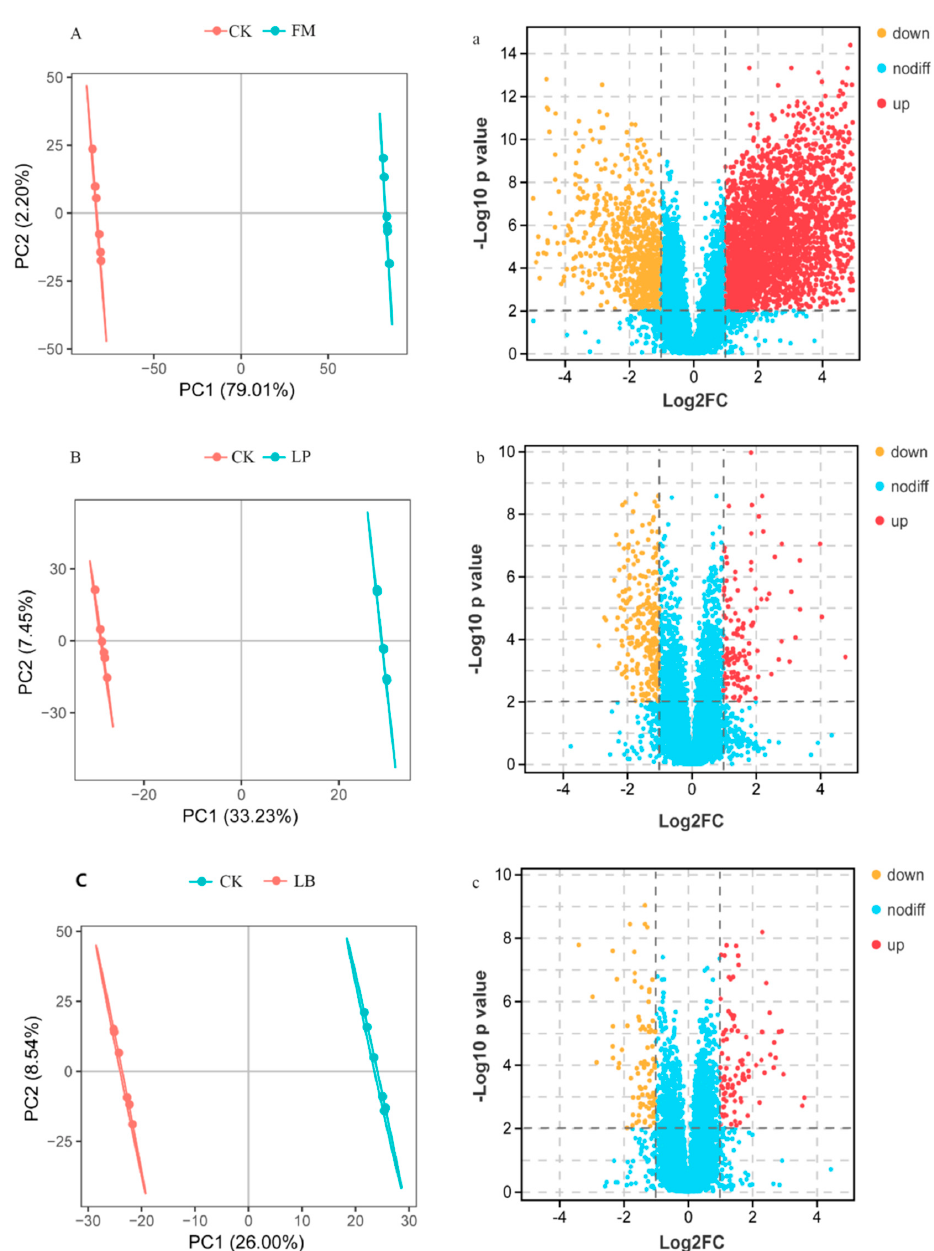
Figure 2. Differential volcano plots of metabolite differences of whole crop corn silage. Note: ( A – C ) is principal component analysis of metabolites in whole crop corn silage with different treatments. ( a – c ) is differential volcano plots of metabolites in whole crop corn silage with different treatments. FM is corn stover. CK, control silage; LP, corn silage treated with Lentilactobacillus plantarum ; LB, corn silage treated with Lentilactobacillus buchneri